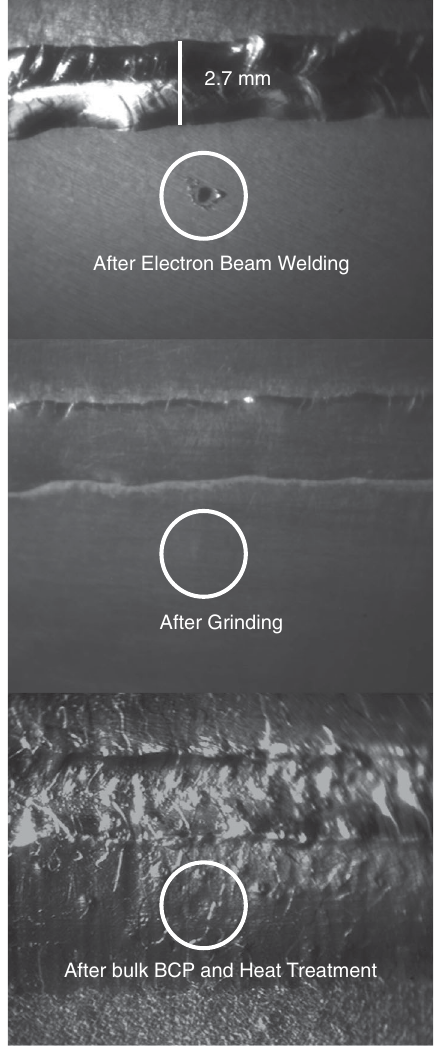
FIG. 2. Cure of a defect in cavity 3HZ004, appearing close to equator 9. Top picture shows the inspection after fabrication, middle picture after the local grinding and bottom picture after the bulk etching BCP process and heat treatment. The dimension of the weld seam is approximately 3 mm in width.